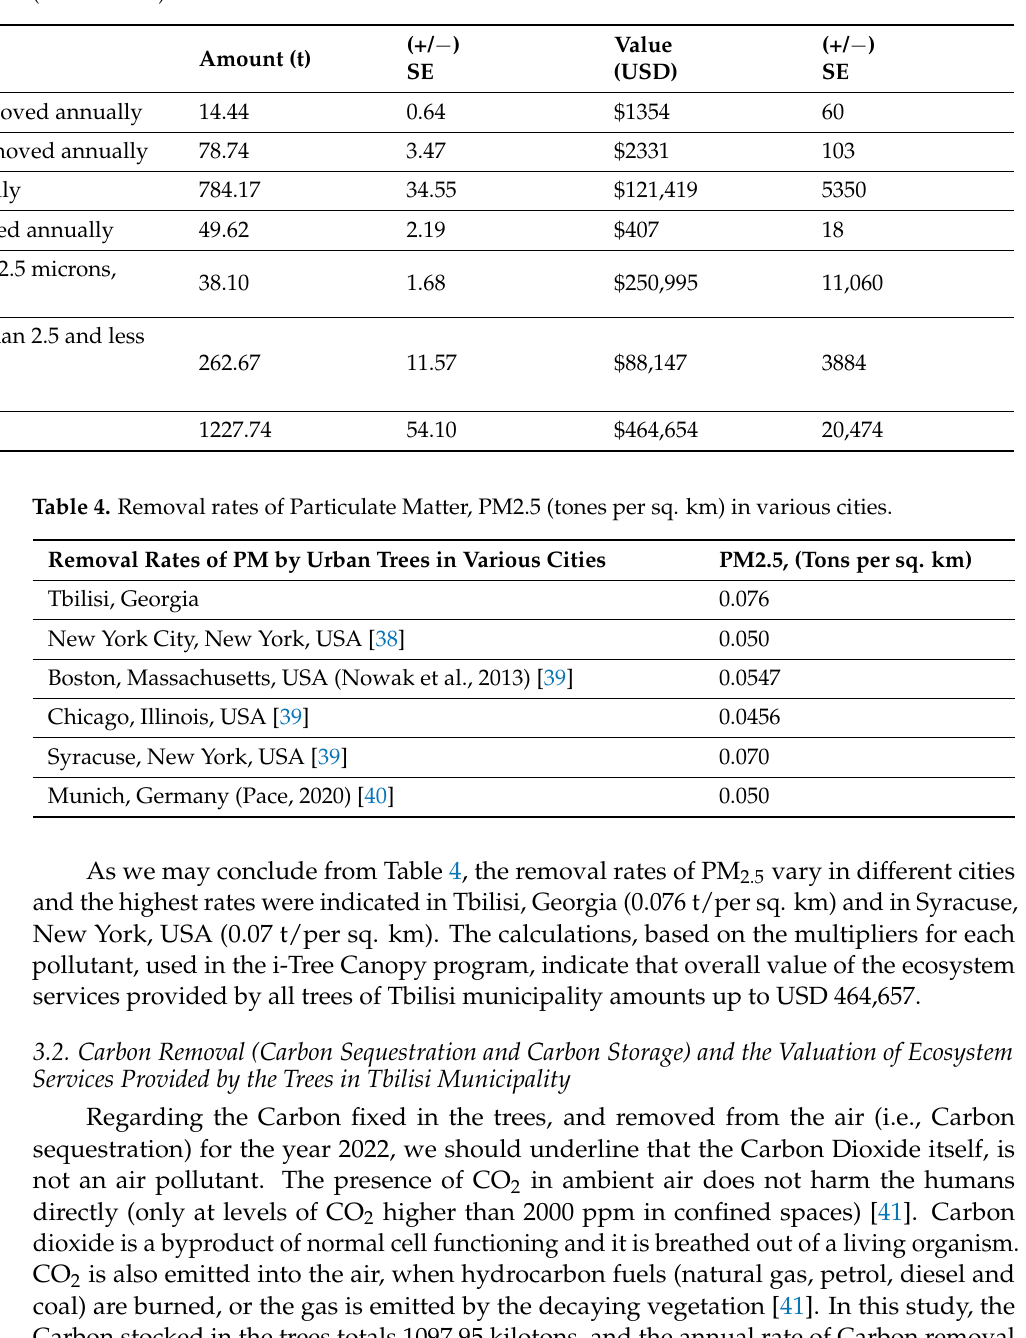
Table 3. Ecosystem Services, provided by the tree cover of Tbilisi municipality—Tree Benefit Estimates (metric units).